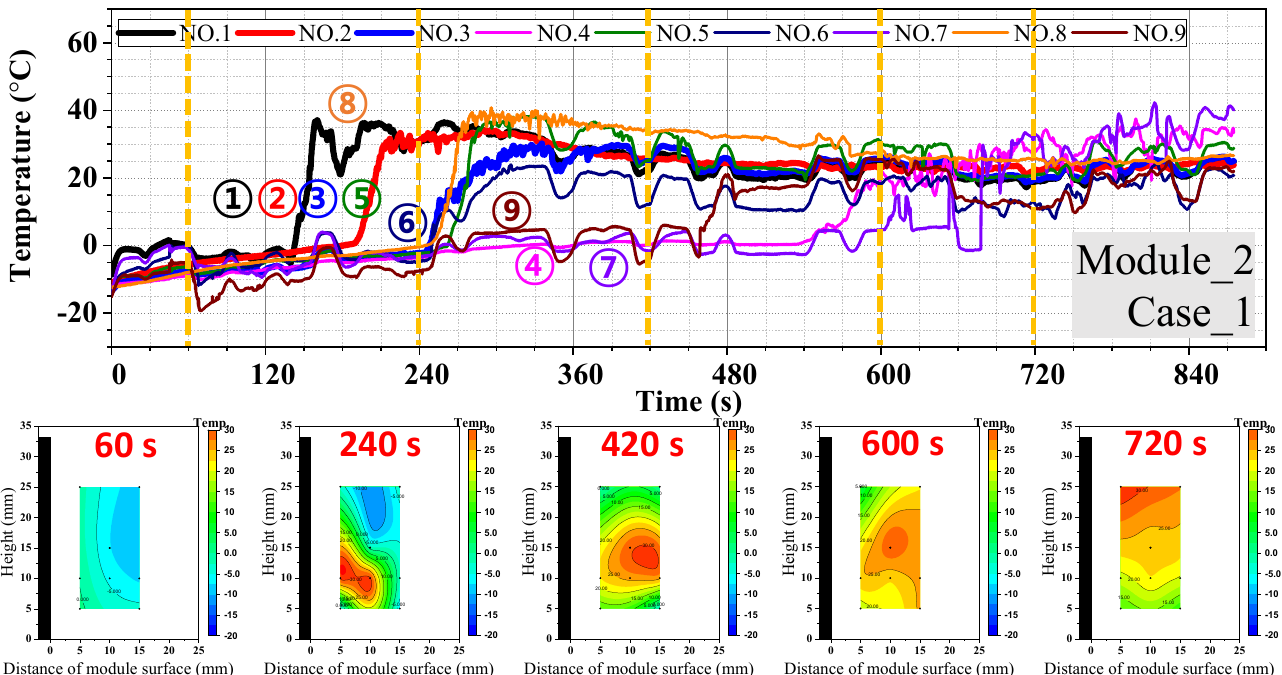
Figure 11. Temperature distribution around the heating module (Module_2) (Case_1). According to the results of the two cases shown in Figure 12, the initial melting pro- ceeded similarly, but the same temperature boundary in the x direction was narrower in Case_2 than it was in Case_1. This is because the heat loss in the upper part of the module was large, and for this reason, the melted solution on the upper part did not spread wide and descended faster toward the bottom. Although there was heat loss in Case_1, we con- firmed that the temperature spread over a wide shape because the ambient temperature was room temperature. In Case_1, the temperature boundary was not clearly distinguish- able from 600 s onward, which seems to indicate that the temperature difference between the melted upper solution and the unmelted solution was not large due to heat inflow from the outside and relatively low heat loss. By contrast, in Case_2, the upper-tempera- ture boundary was clearly maintained even at 600 s and 720 s, meaning that the tempera- ture difference was maintained owing to rapid heat loss. Temp.